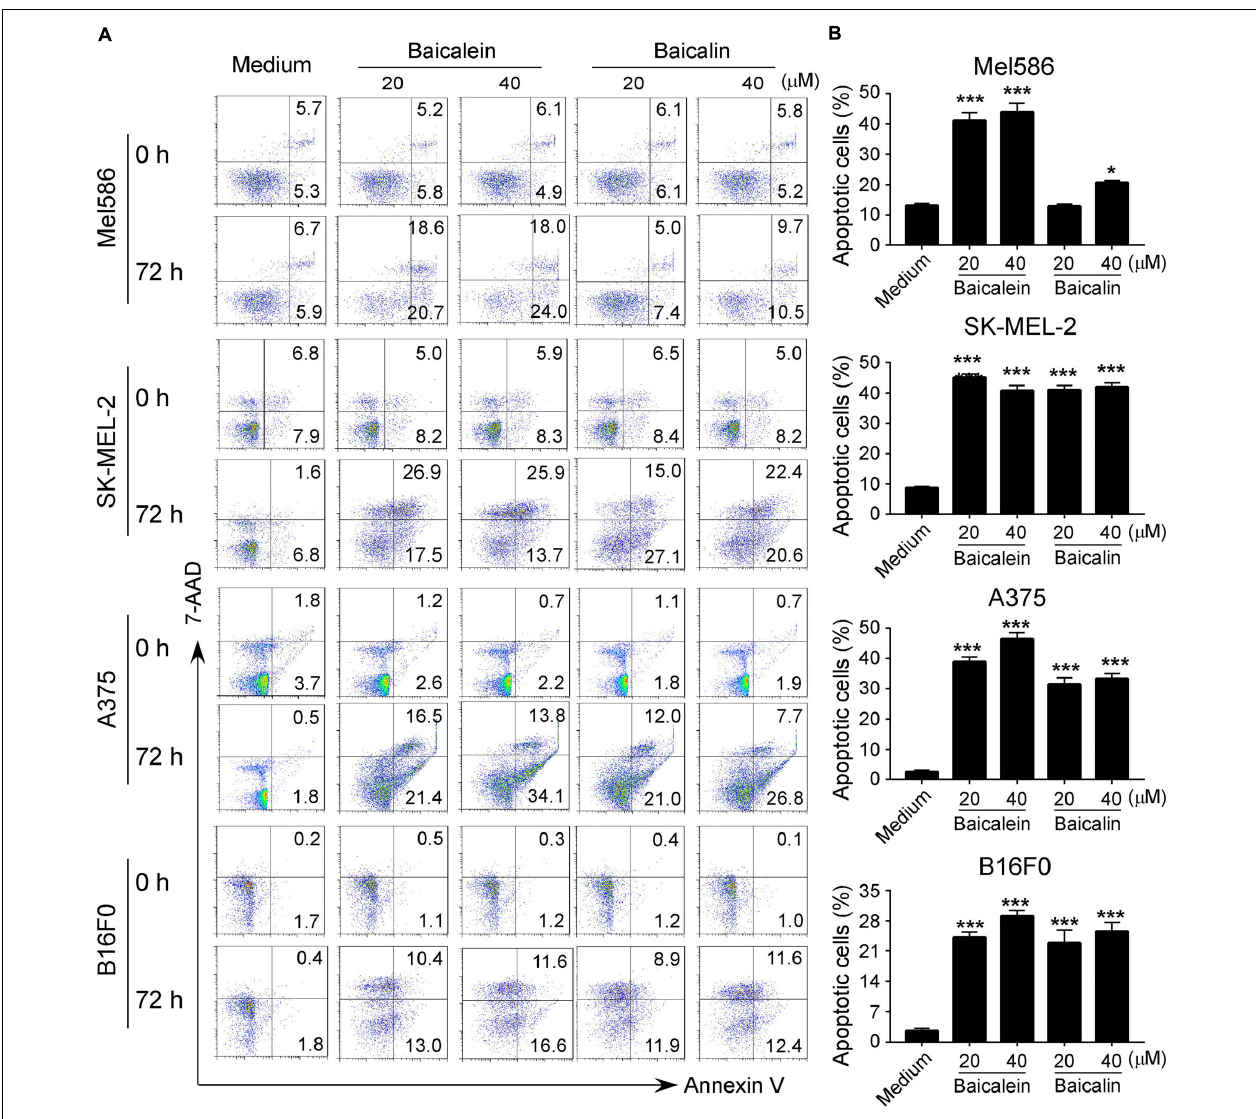
FIGURE 3 | Baicalein and baicalin treatments promote melanoma cell apoptosis. (A,B) Significantly increased apoptotic cell populations were induced in both human and mouse melanoma cells after treatments with baicalein and baicalin. Tumor cells were cultured in the presence of indicated concentrations of baicalein and baicalin for 72 h. Apoptosis in treated tumor cells was analyzed after staining with PE-labeled Annexin V and 7-AAD (A) . Results shown in the histogram (B) are summaries of mean ± SD from three independent experiments. * p < 0.05 and *** p < 0.001, compared with the medium control